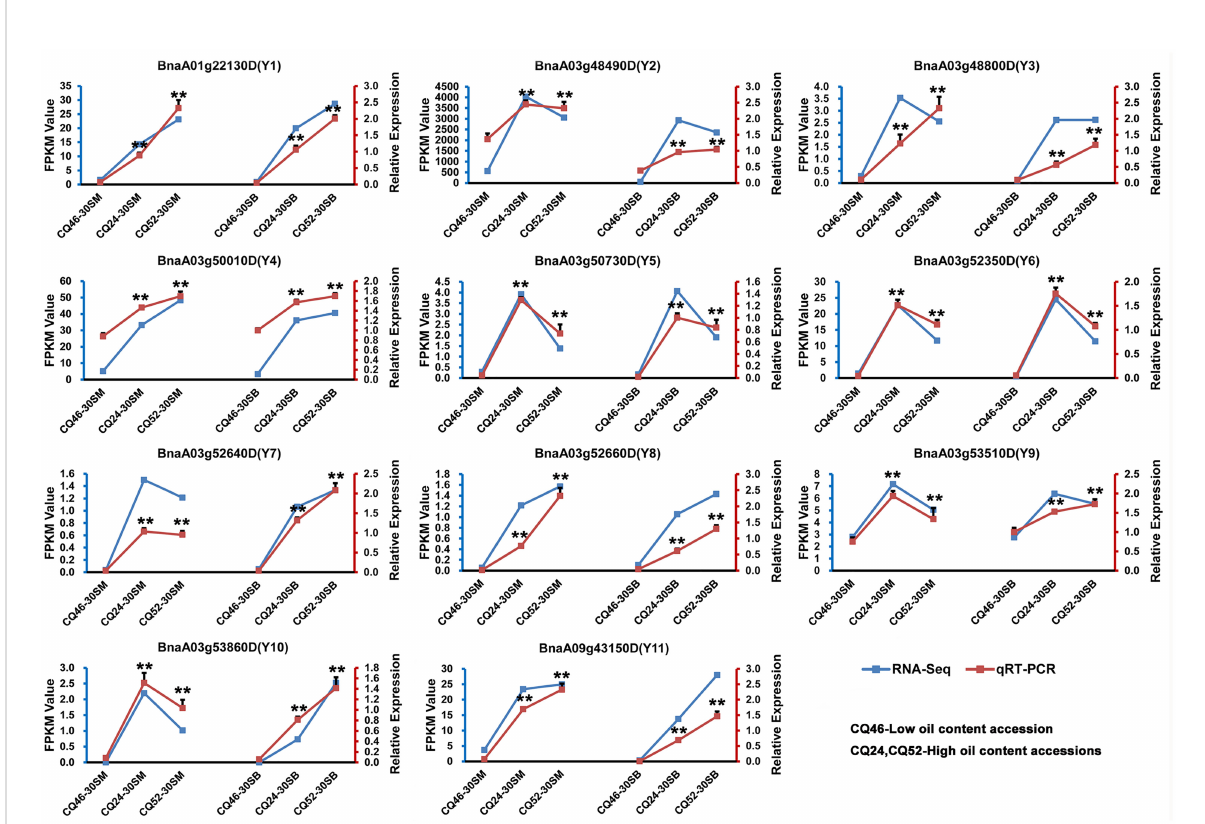
FIGURE 3 qRT-PCR analysis con fi rmed the accuracy of transcriptome sequencing by validating the expression patterns of 11 candidate genes in seeds 30 days after fl owering on the main in fl orescence (30SM) and on the primary branch (30SB). The blue line represents the RNA-Seq results and the red line represents the qRT-PCR results. **Denotes signi fi cance differences with P < 0.01, based on Student ’ s t